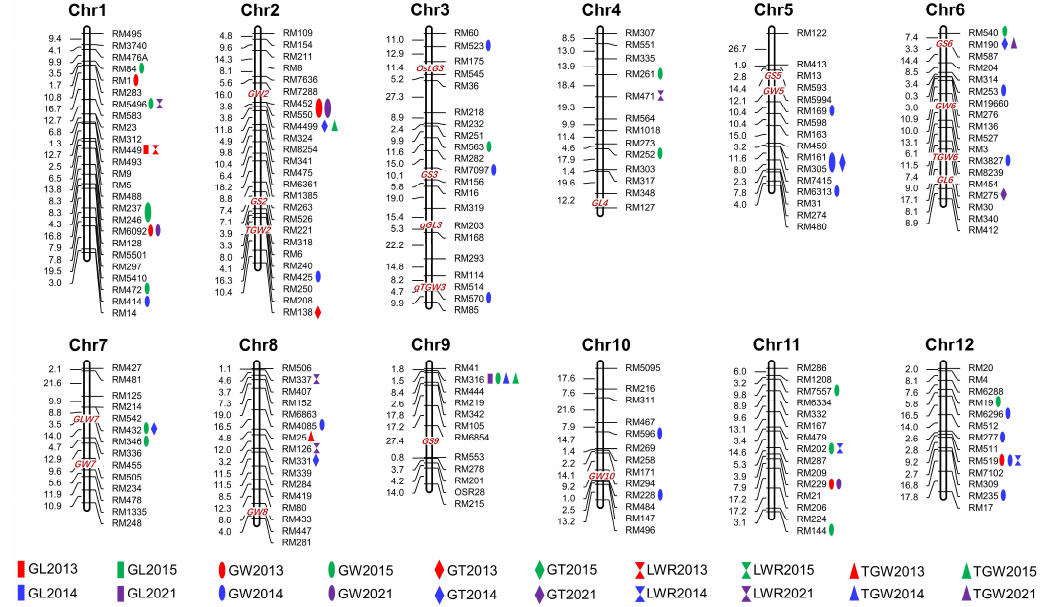
Figure 5. Distribution of significant marker associations for five grain traits. Red, green, blue, and pink shapes indicate 2013, 2014, 2015, and 2021, respectively.